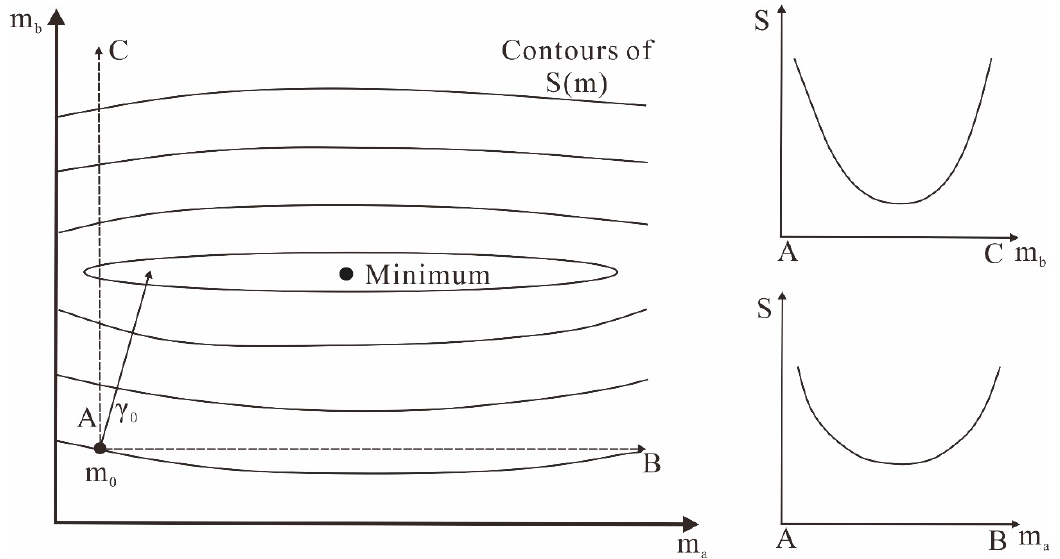
Figure 7. The principle of thee subspace method [59]. The left panel shows a contour of S(m), which is a function of two parameters of different physical dimensions. The right panel suggests that S(m) is more sensitive to m b than m a .